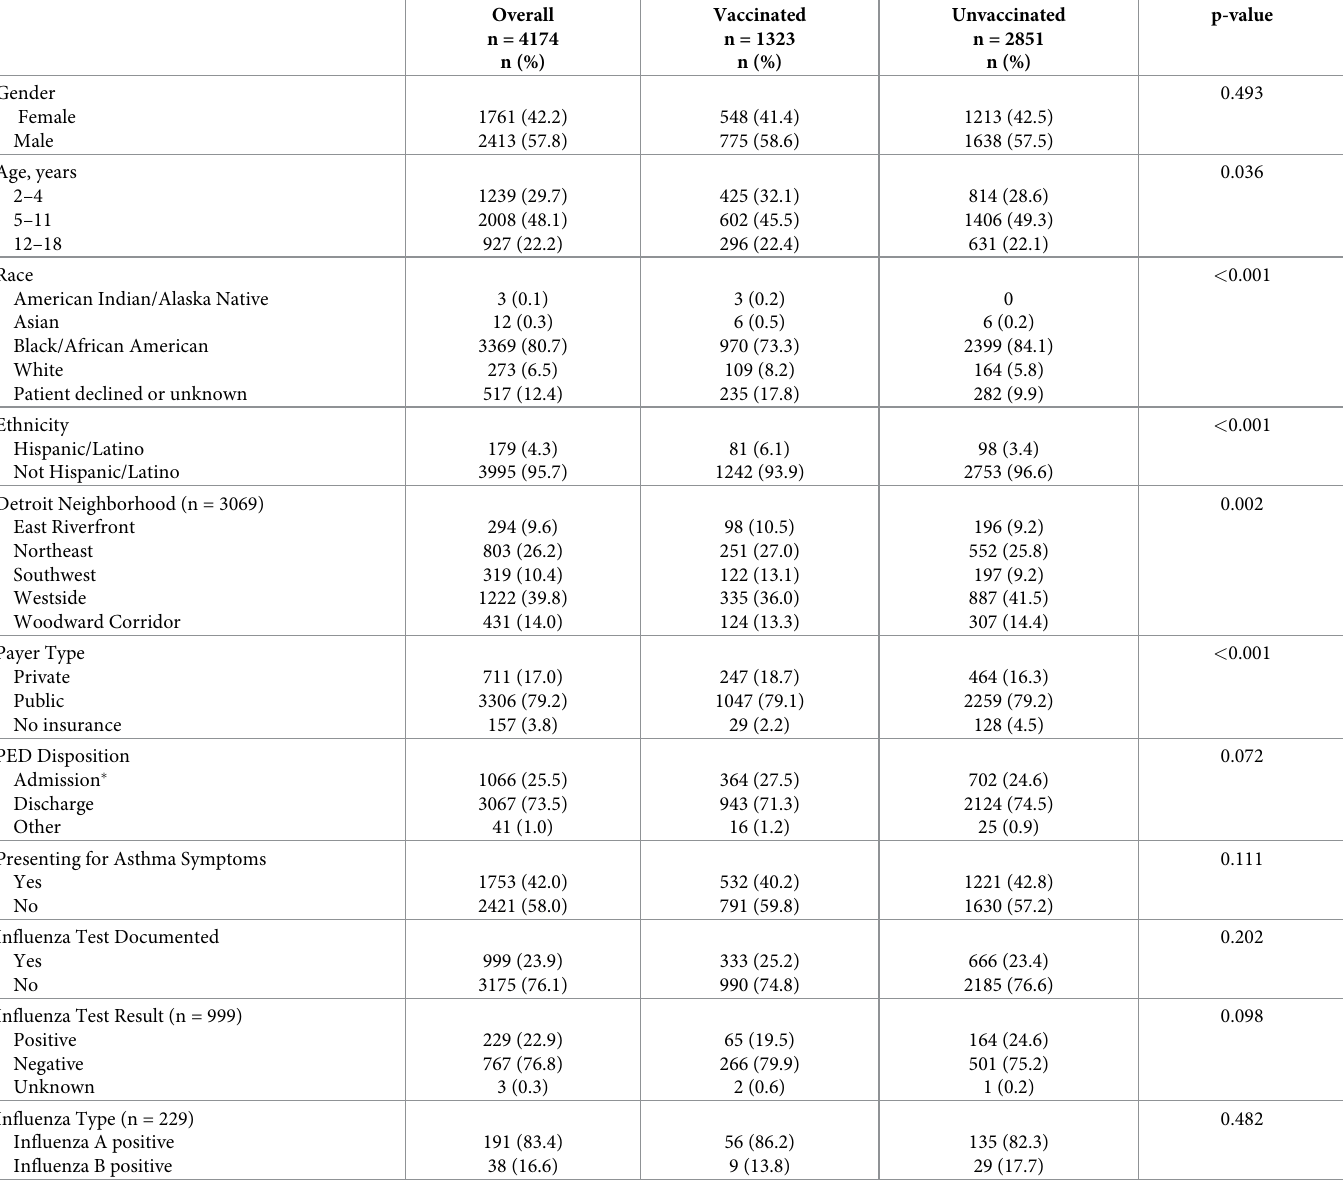
Table 1. Study population demographics and clinical characteristics according to vaccination